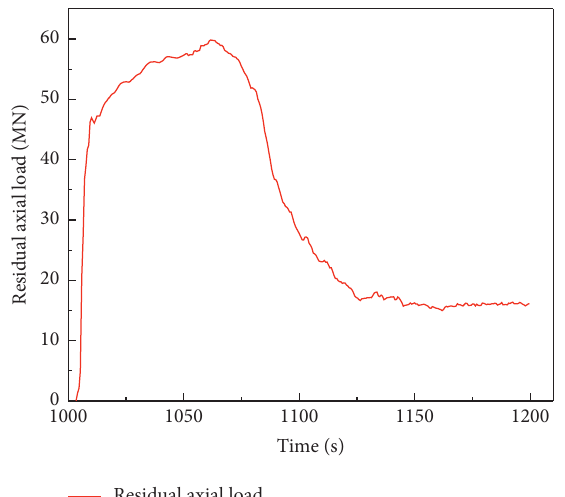
Figure 8: Residual axial load-time history curve of the pier at the third stage.